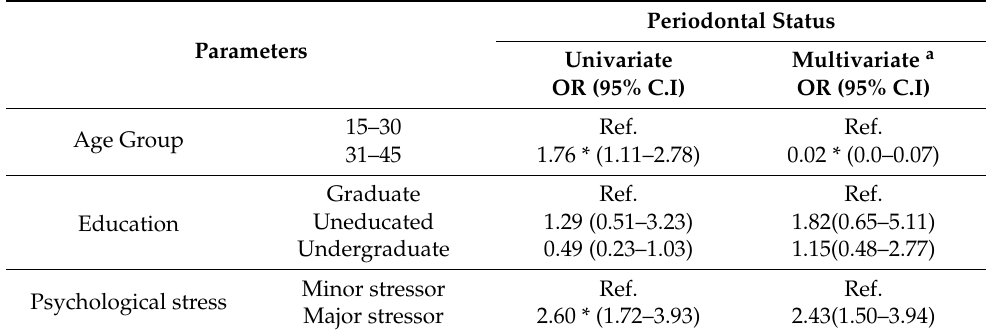
Table 3. Risk estimation of periodontal disease with studied